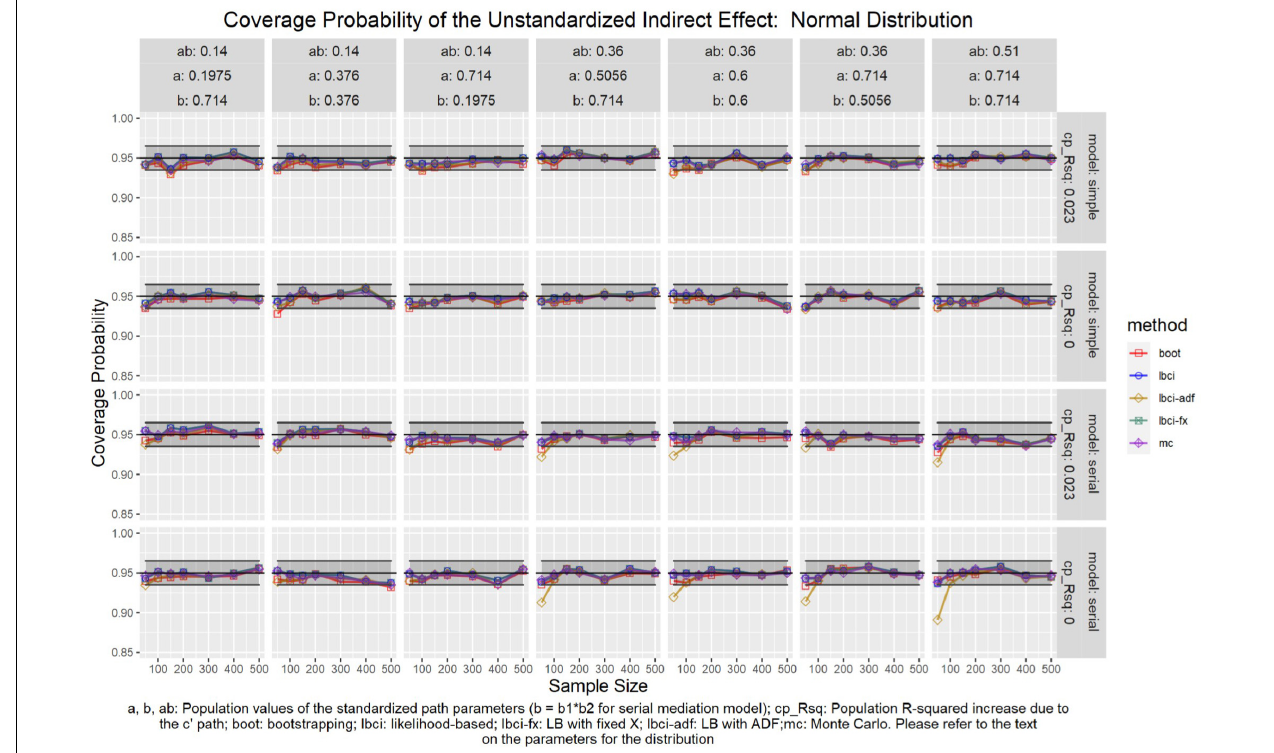
FIGURE 5 | Normal Distribution (Unstandardized Indirect Effect). a, b, ab: Population values of the standardized path parameters (b = b1 × b2 for serial mediation model); cp_Rsq: Population R-squared increase due to the c (cid:48) path; boot: bootstrapping; Ibci: likelihood-based; Ibci-fx: LB with fixed X; Ibci-adf: LB with ADF;mc: Monte Carlo. Please refer to the text on the parameters for the